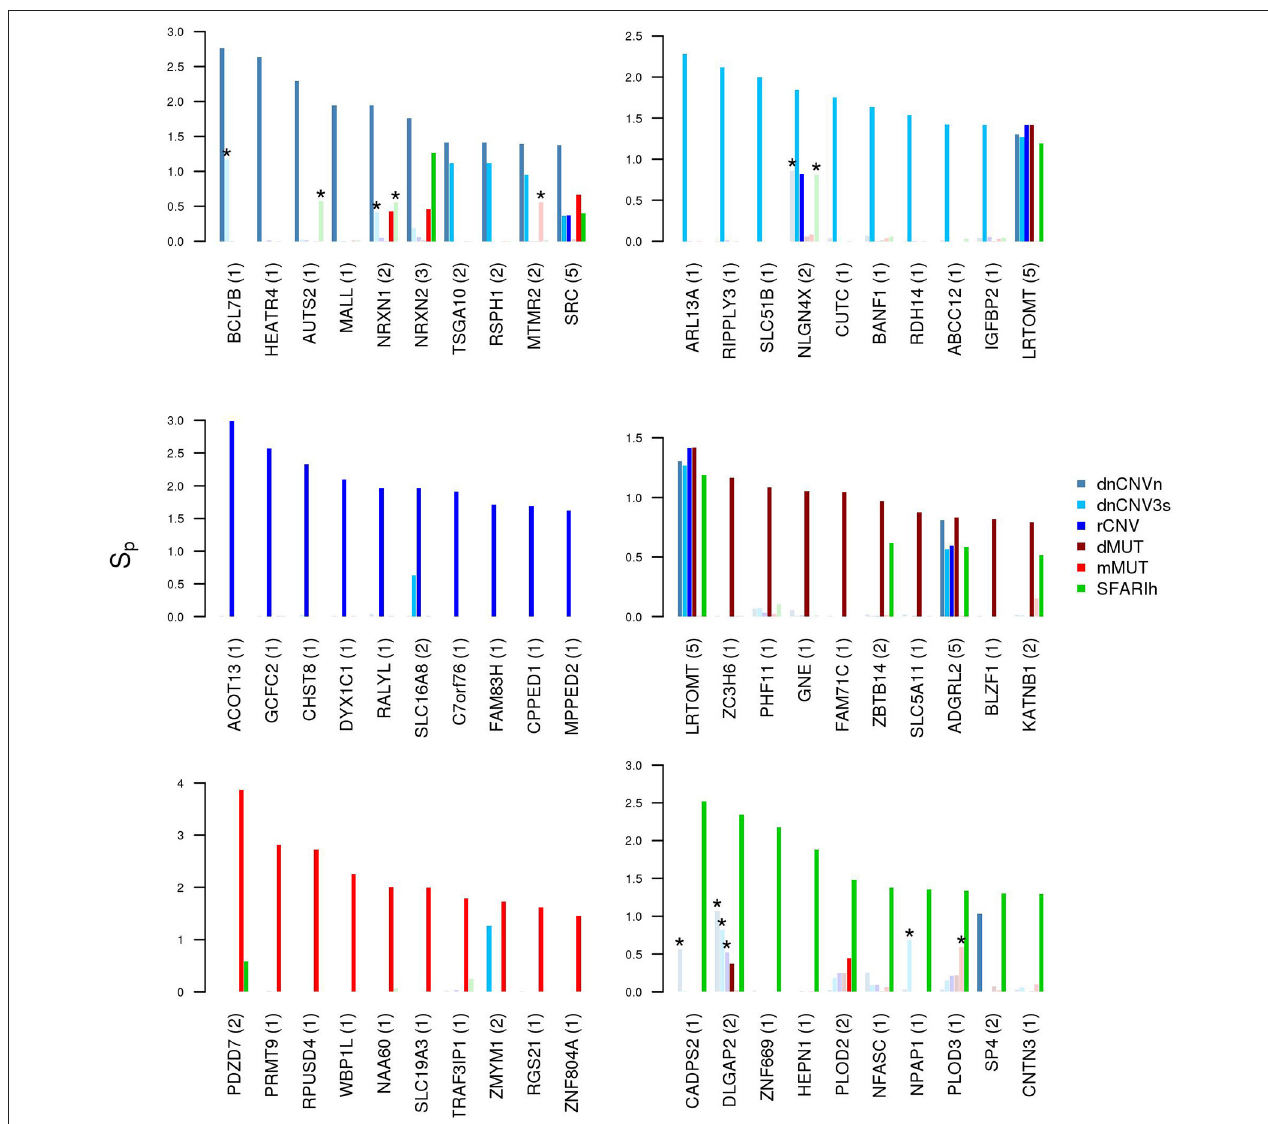
FIGURE 5 | Genes in network proximity to ASD risk genes from each study. Top 10 genes with the highest permutation-adjusted network smoothing index ( Sp ) calculated in the analysis of each ASD risk gene list; the number of lists to which the gene was predicted as network proximal is reported between parenthesis; the asterisk (*) indicates genes of the corresponding original list; faded colors indicate input ASD risk genes or genes with no significant Sp